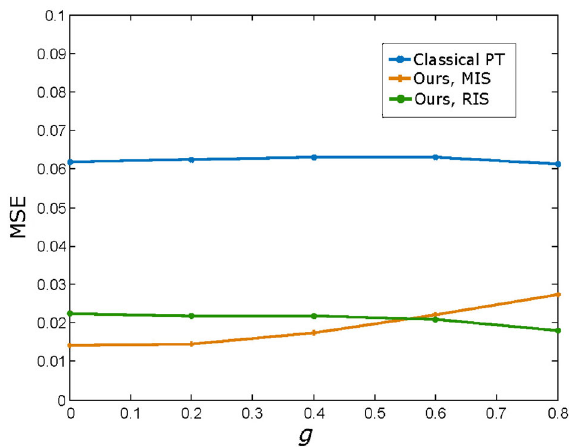
Fig. 16 Error (MSE) for our method with multiple importance sampling, our method with resampled importance sampling, and path tracing with equal time (about 20 minutes), as a function of media anisotropy, for the Candle